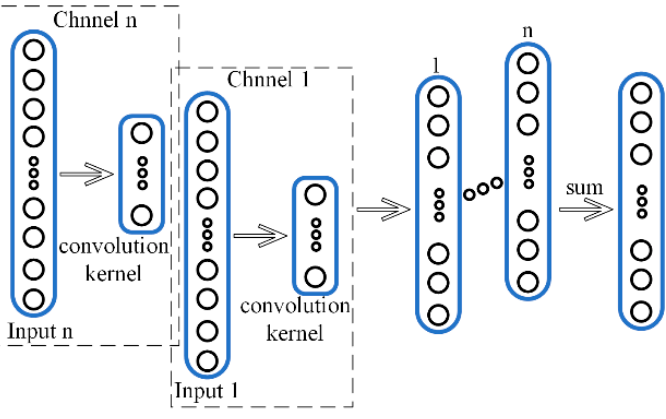
Figure 6. Multi-channel one-dimension convolutional fusion.